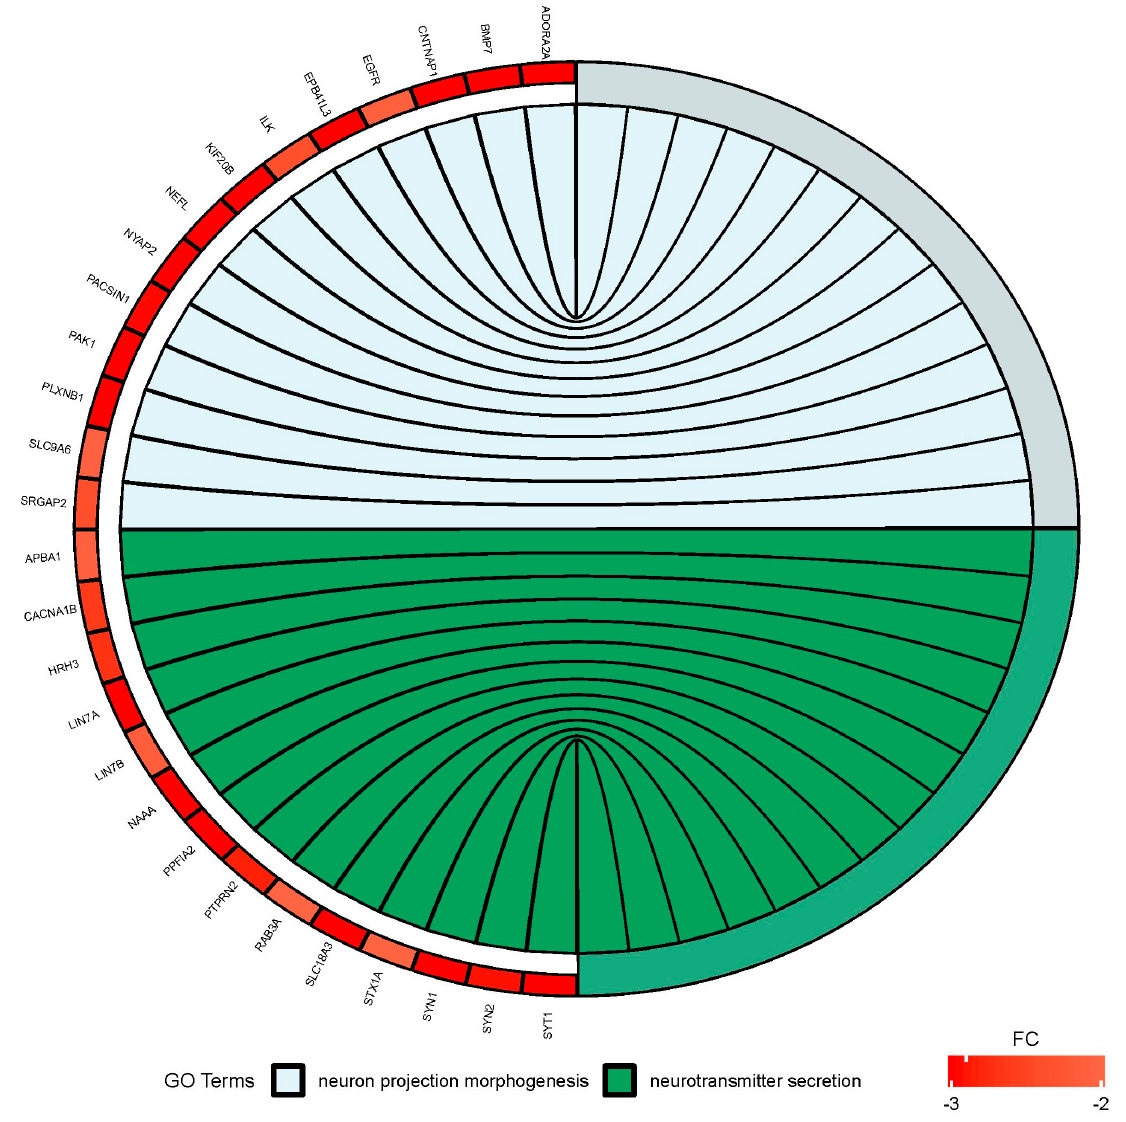
Figure 6. Circus plot shows the dysregulated processes (neuron projection morphogenesis and neurotransmitter secretion) and their associated genes after bortezomib-treatment in PC12-derived nerve cells. The level of expression for each gene is marked using red color (fold change − 3 to − 2).